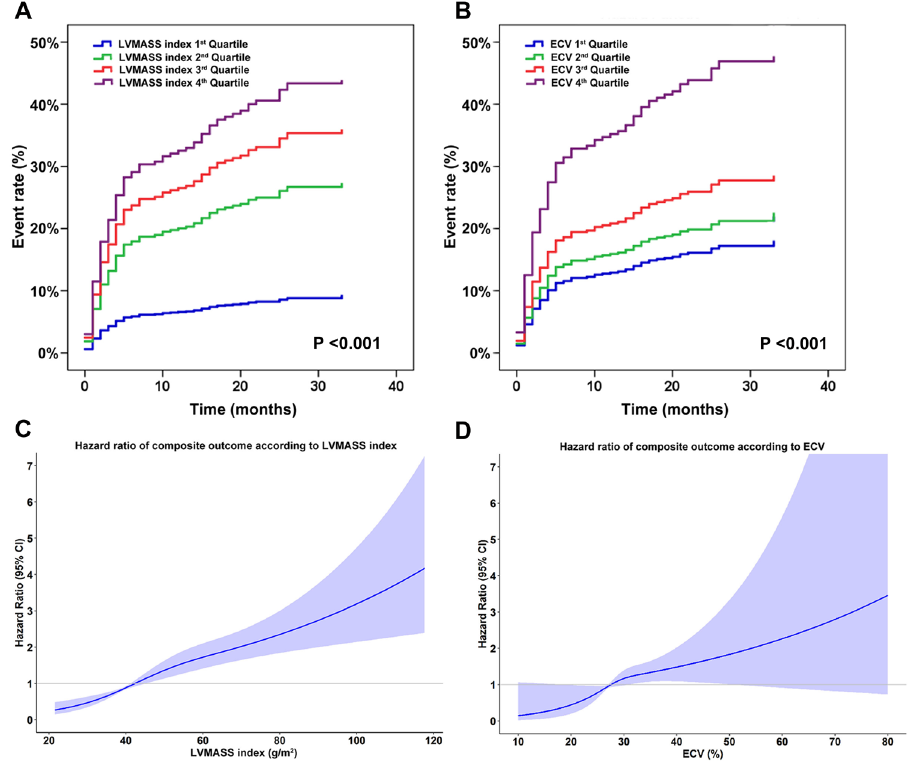
Figure 6. Sensitivity analysis. ( A and B ) The effect of left ventricular mass (LVMASS) index and extracellular volume (ECV) on composite outcomes when the variables were subdivided into quartiles. ( C and D ) Cubic spline graphs showing the effect of LVMASS index and ECV on composite outcomes when the variables were treated as continuous